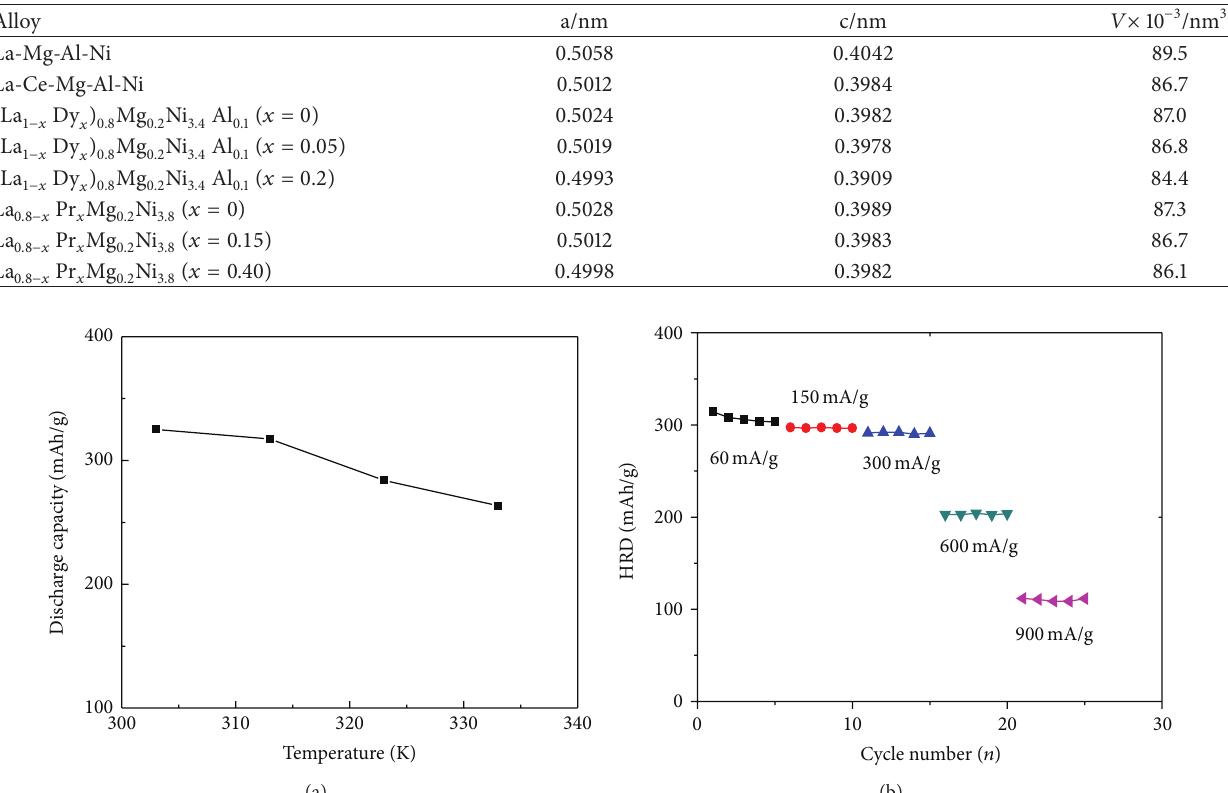
Table 1: Lattice constant and cell volume for La-RE-Mg-Al-Ni phydrogen storage alloys [22, 23, 25].